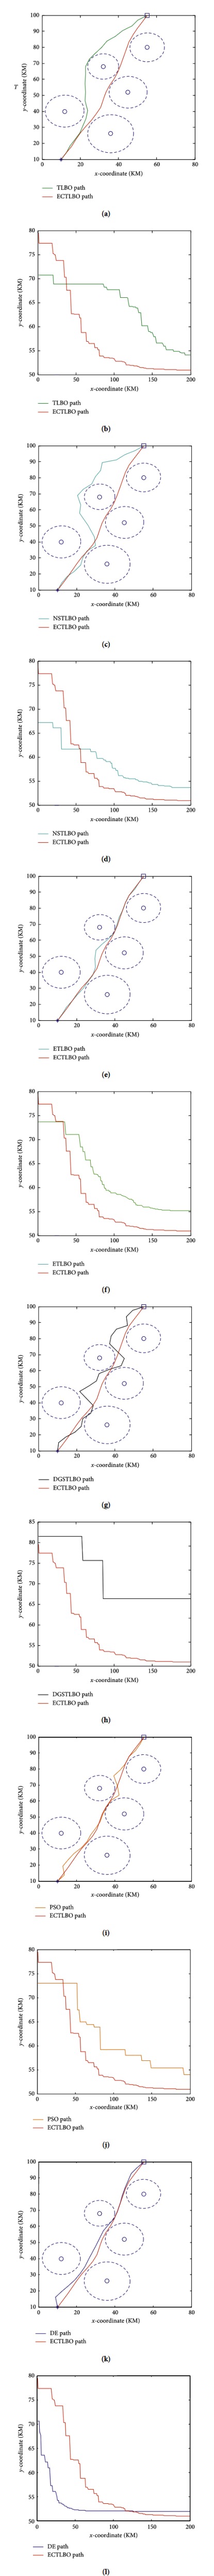
Optimal flight routes and evolutionary curves derived from seven algorithms.